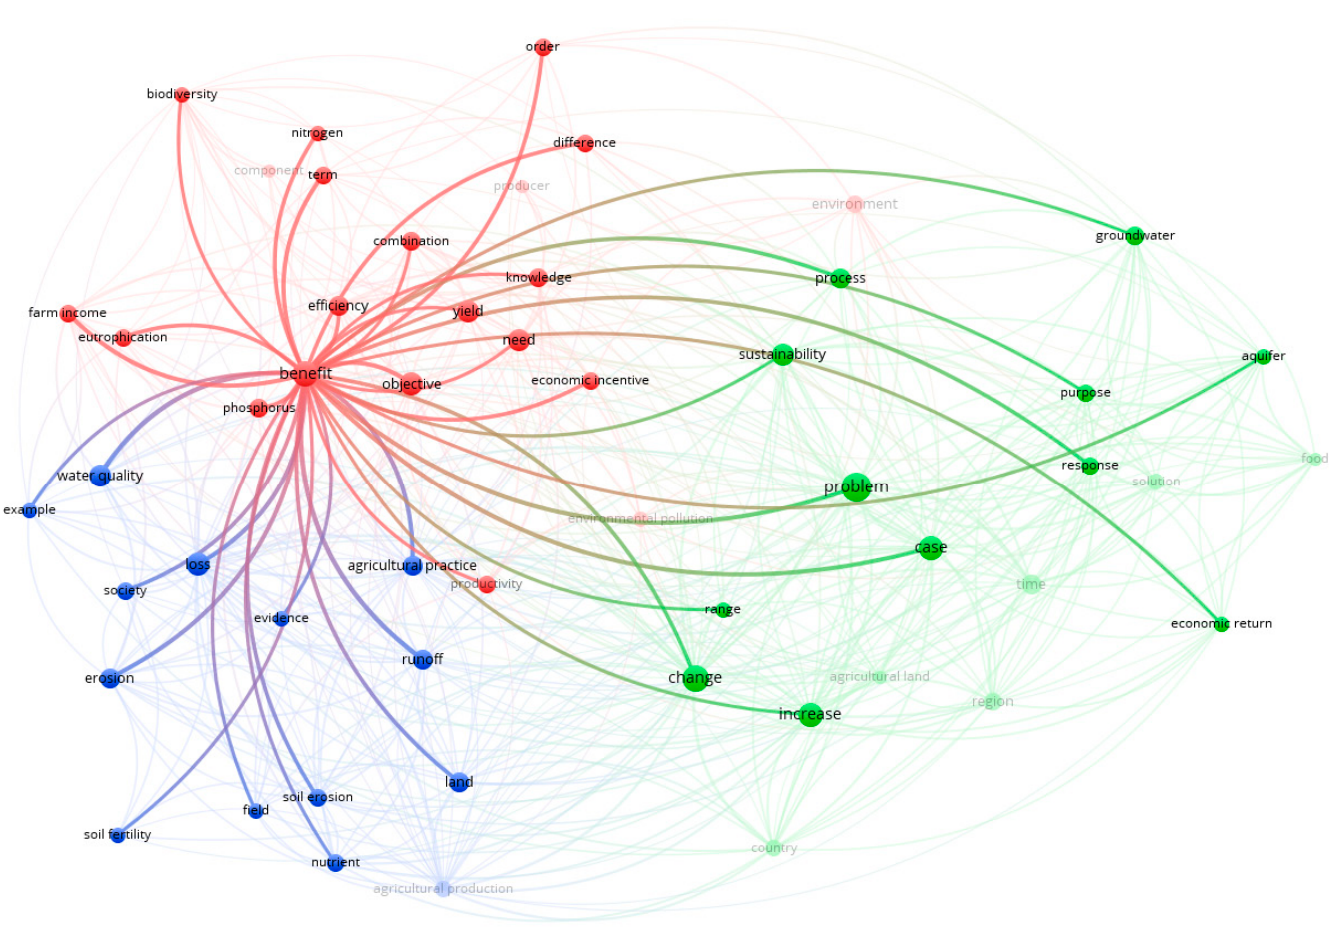
Figure 2. Interrelationships with the term “benefit” from cluster 1.